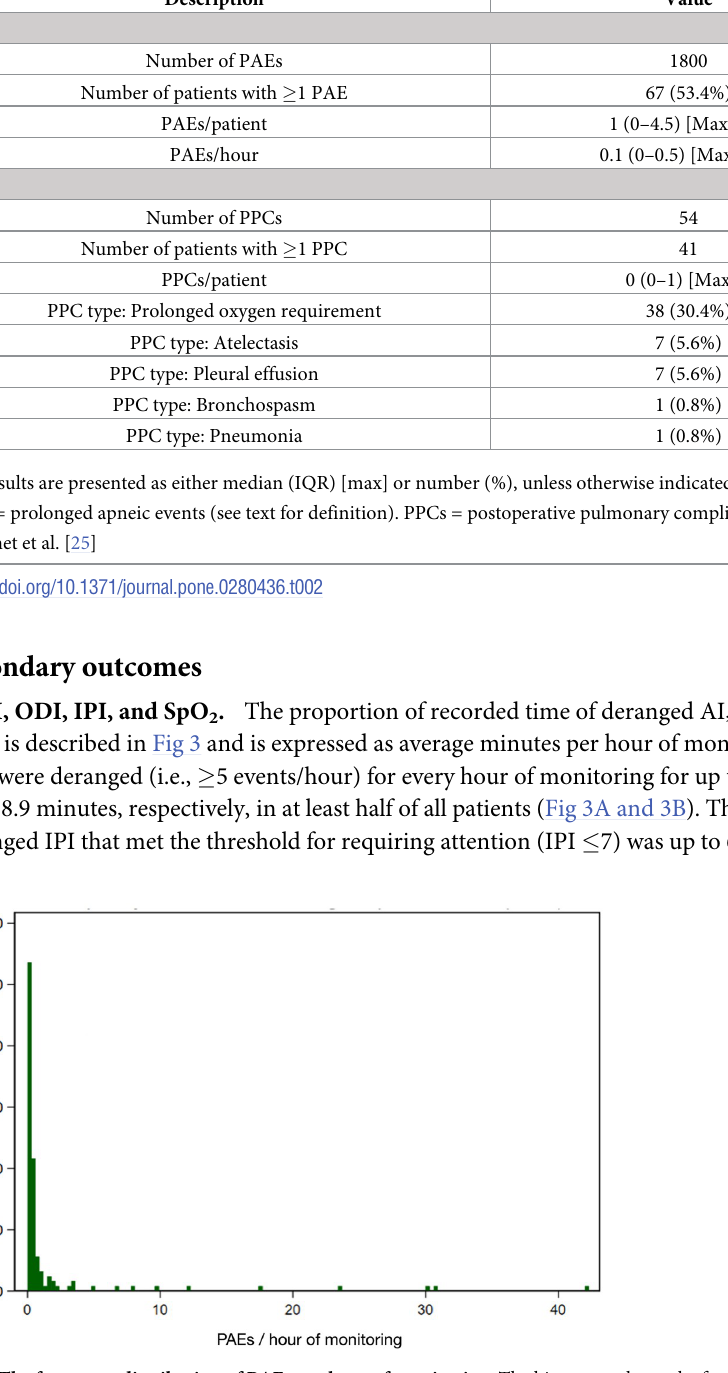
Fig 2. The frequency distribution of PAEs per hour of monitoring. The histogram shows the frequency of PAEs in an average hour of monitoring. 58 (46.4%) patients had 0 events/hour. The highest quartile of patients experienced 0.5–42.2 events/hour. PAEs = prolonged apnea events, defined as the number of times during the monitoring period of 2200 to 0800 after the first postoperative night that EtCO 2 � 5 mmHg for 30–120 seconds or EtCO 2 � 5 mmHg for > 120 seconds in association with SpO 2 �